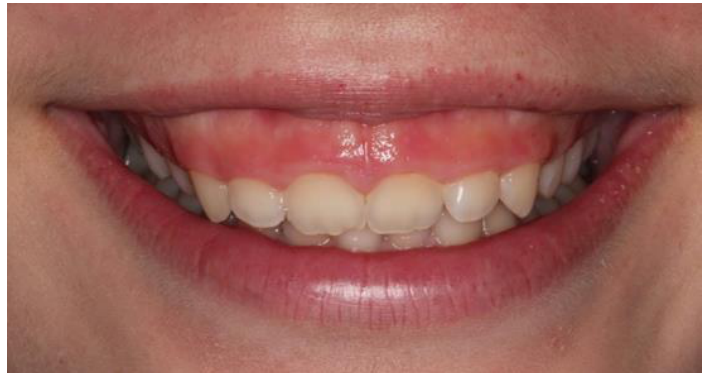
Figure 1. Gingival smile and deep bite.